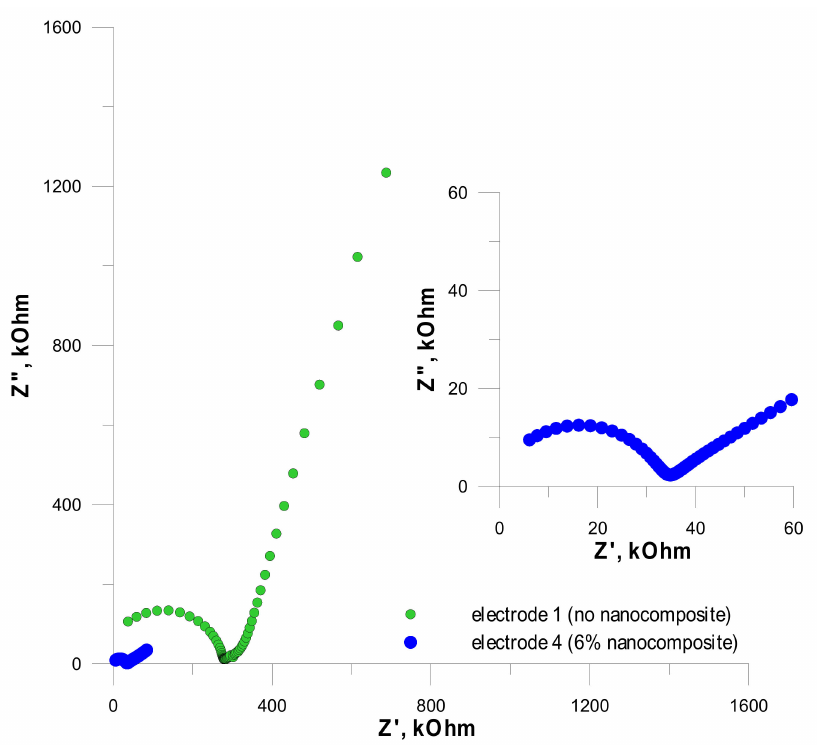
Figure 11. Impedance spectra of electrode 4 based on MWCNTs-BMImPF 6 nanocomposite and unmodified electrode 1 determined in 1 × 10 − 2 mol L − 1 Cu(NO 3 ) 2 solution. Frequency range 0.1–100 kHz, amplitude 10